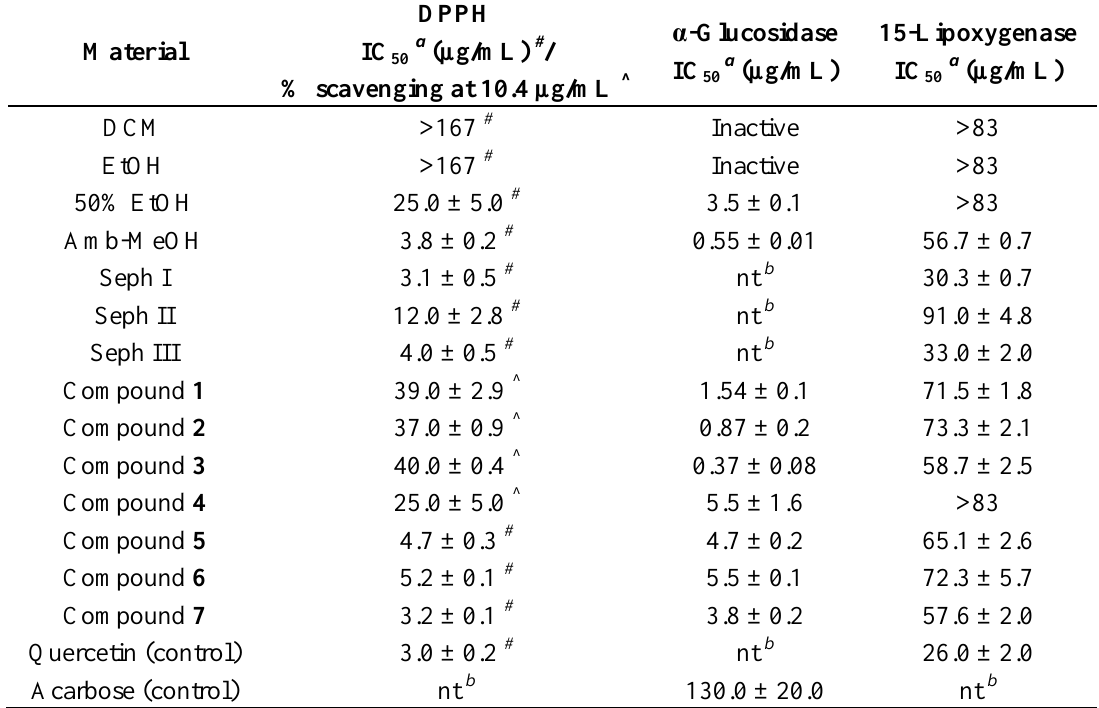
Table 2. Scavenging of the diphenylpicrylhydrazyl (DPPH) radical, 15-LO and α-glucosidase inhibitory activity of Aronia extracts, fractions and